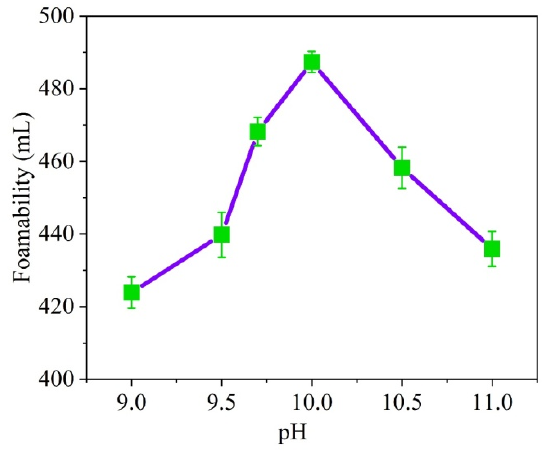
Figure 1. Effect of pH value on foaming ability.